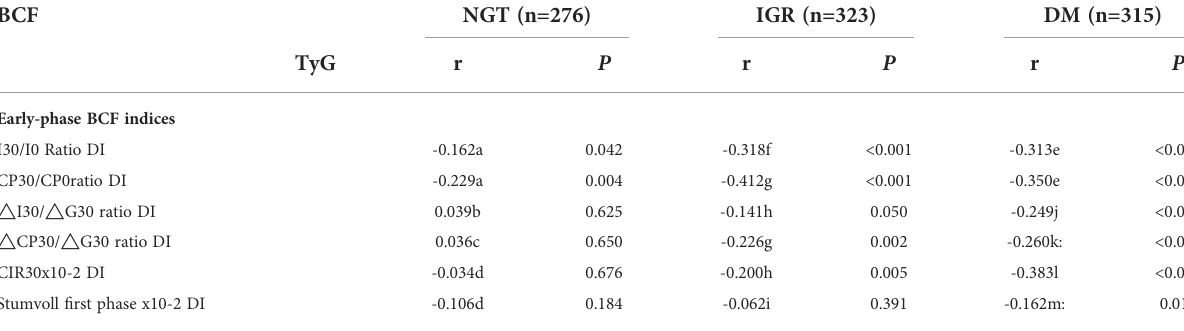
TABLE 5A Correlation coef fi cients between early-phase BCF indices and TyG index in subgroups with different glucose metabolic statuses.